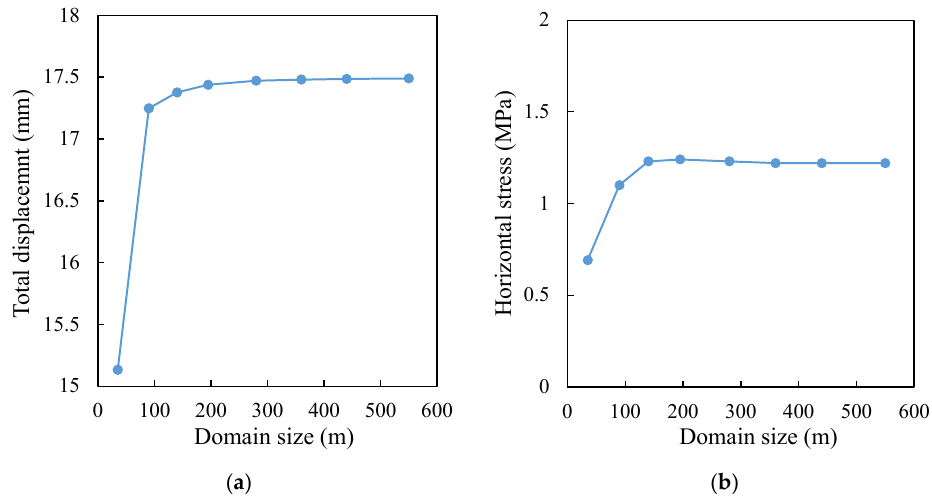
Figure A13. Variation of ( a ) total displacement at Point A after extracting the overlying stope and ( b ) vertical stress at Point B after excavating the underlying stope as functions of domain size. Figure A14 shows the variation of total displacement at Point A and horizontal stress at Point B as functions of the mesh size, which ranges from 5 to 0.1 m. The numerical results become stable when the mesh size reduces to 0.5 m.